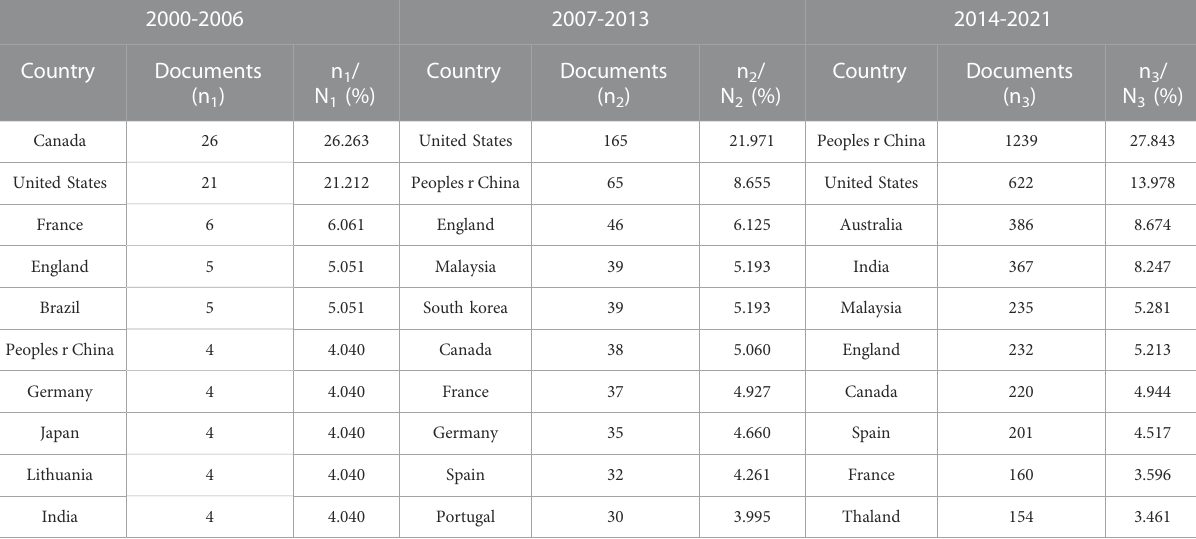
TABLE 4 Distribution of top 10 countries with high publication volume of ecological concrete in 3 phases.